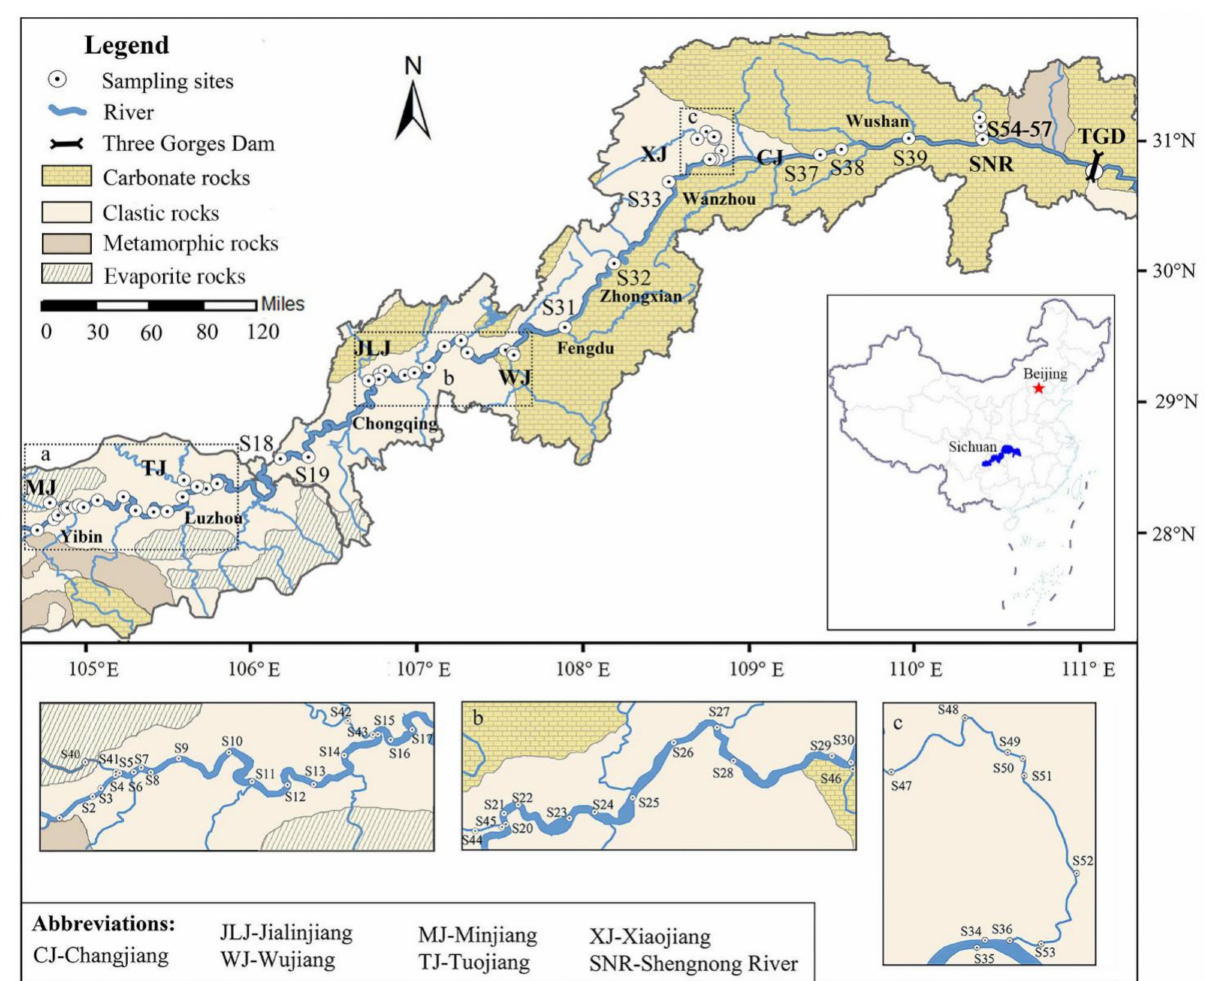
Figure 1. The sampling sites upstream of the Three Gorges Reservoir (TGR). Sampling sites include the main channel (start from Yibin in the west) and some tributaries (Minjiang River, Tuojiang River, Jialingjiang River, Wujiang River, Xiaojiang River and Shennong River) of Changjiang River, located between longitudes 104 ◦ 26 (cid:48) to 110 ◦ 19 (cid:48) and latitudes 28 ◦ 37 (cid:48) to 31 ◦ 11 (cid:48) . The elevation of the sampling sites is approximately between 64 and 270 m. The farthest sampling site (S1) from TGD is at Yibin City, nearly 994 km from the